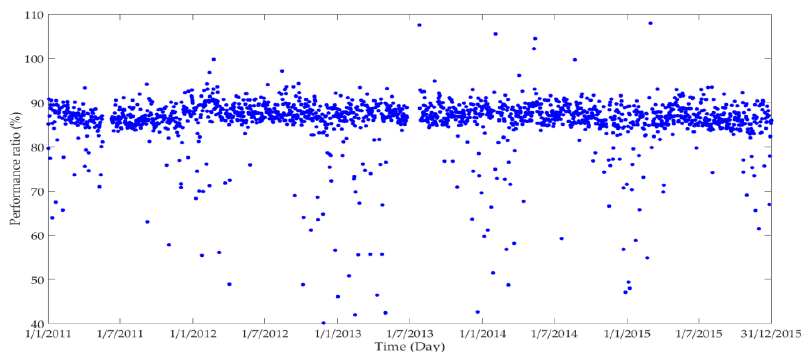
Figure 6. Daily PR from 1 January 2011 to 31 December 2015.